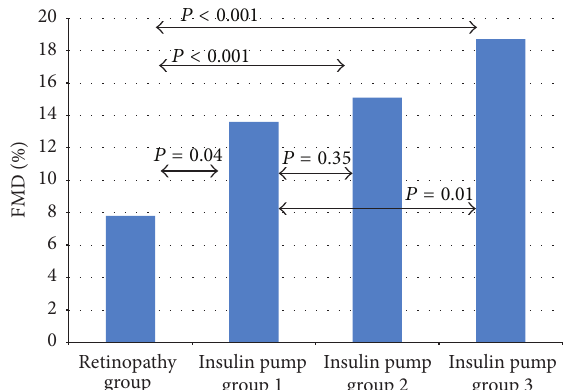
Figure 3: FMD values in the study groups: retinopathy group compared to the pump group before implementation of CSII (insulin pump group 1), after 3 months (insulin pump group 2) and after 6 months (insulin pump group